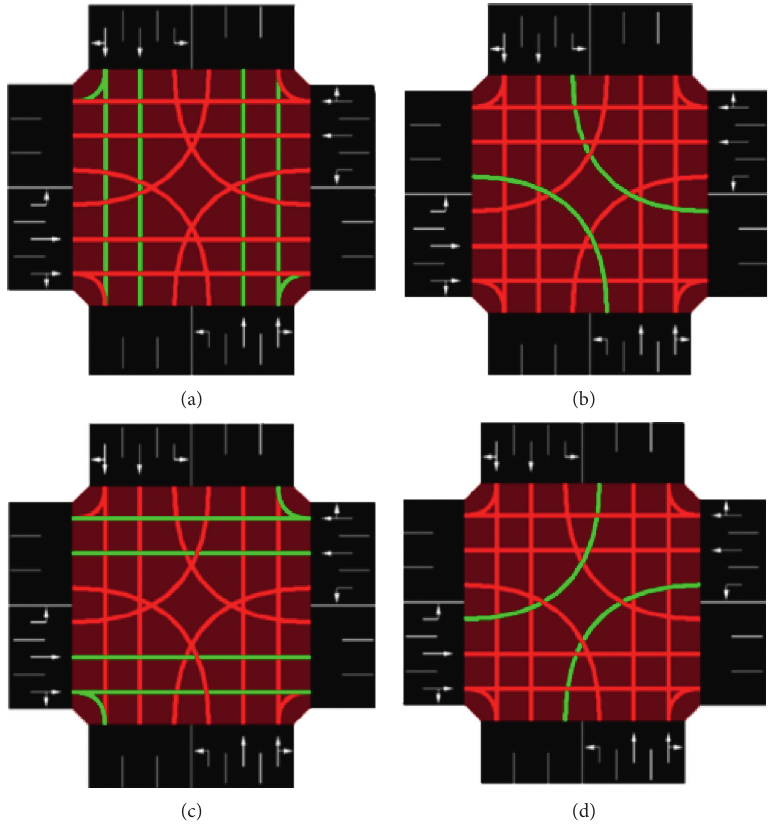
Figure 6: Sequence of traffic signal phases. (a) NSG. (b) NSLG. (c) EWG. (d)